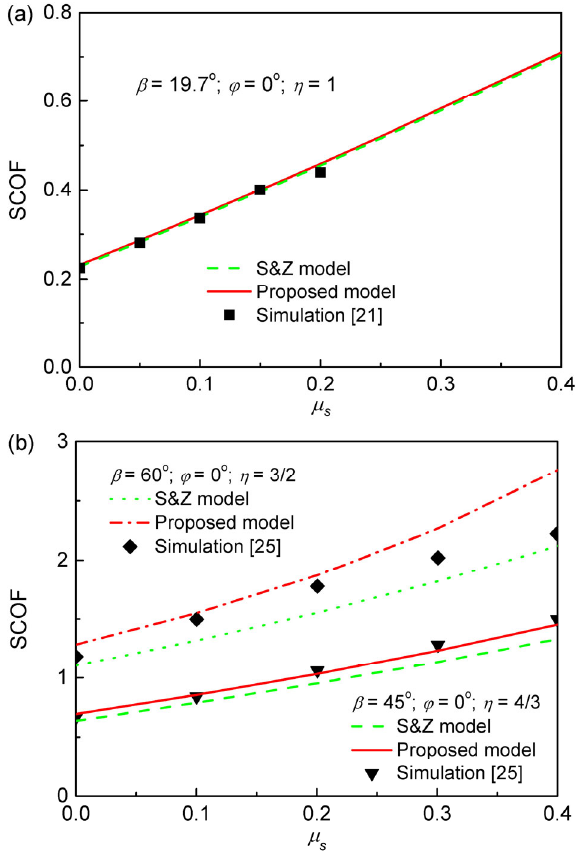
Fig. 7 SCOFs (ignoring the substrate recovery) as a function of  : (a)  = 19.7°, (b)  = 45° and s